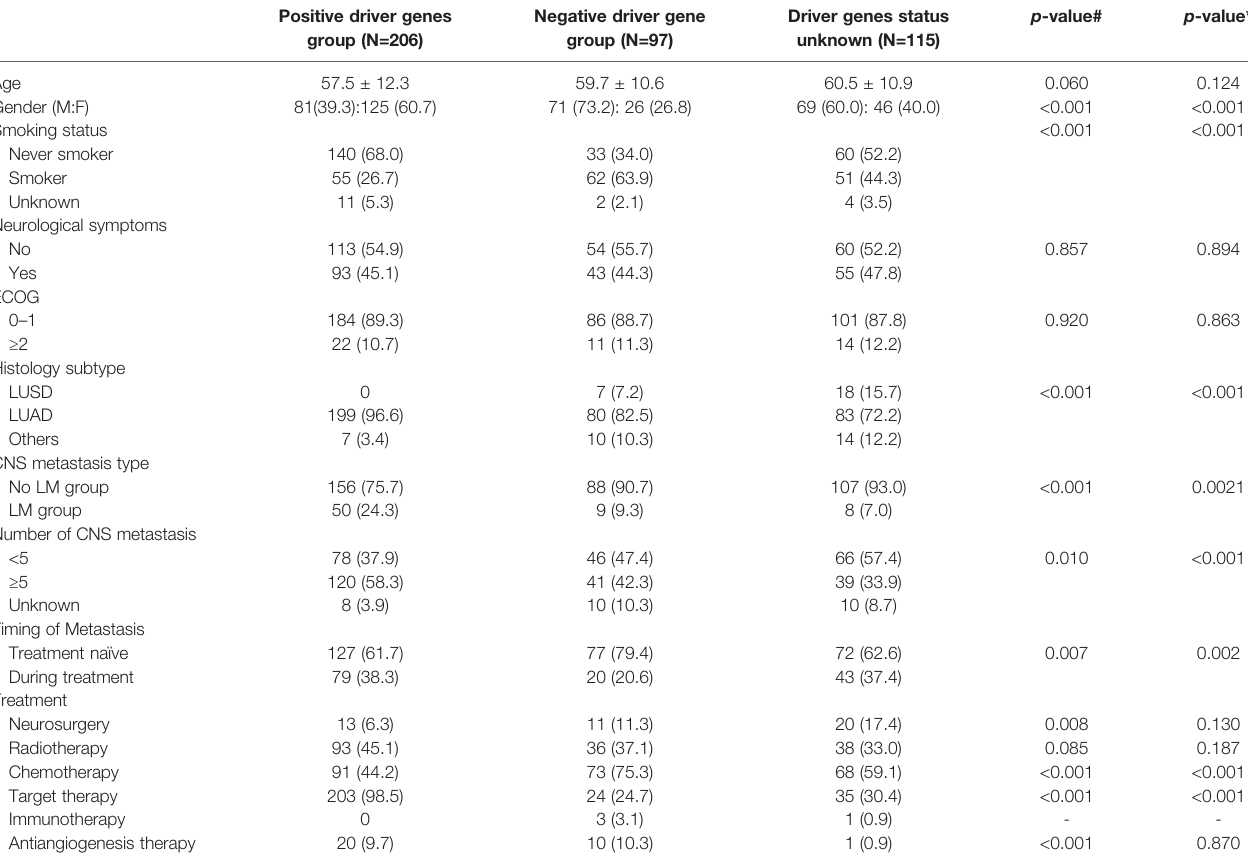
TABLE 2 | Clinical characteristics of NSCLC patients with positive driver genes, negative driver genes, and unknown driver genes